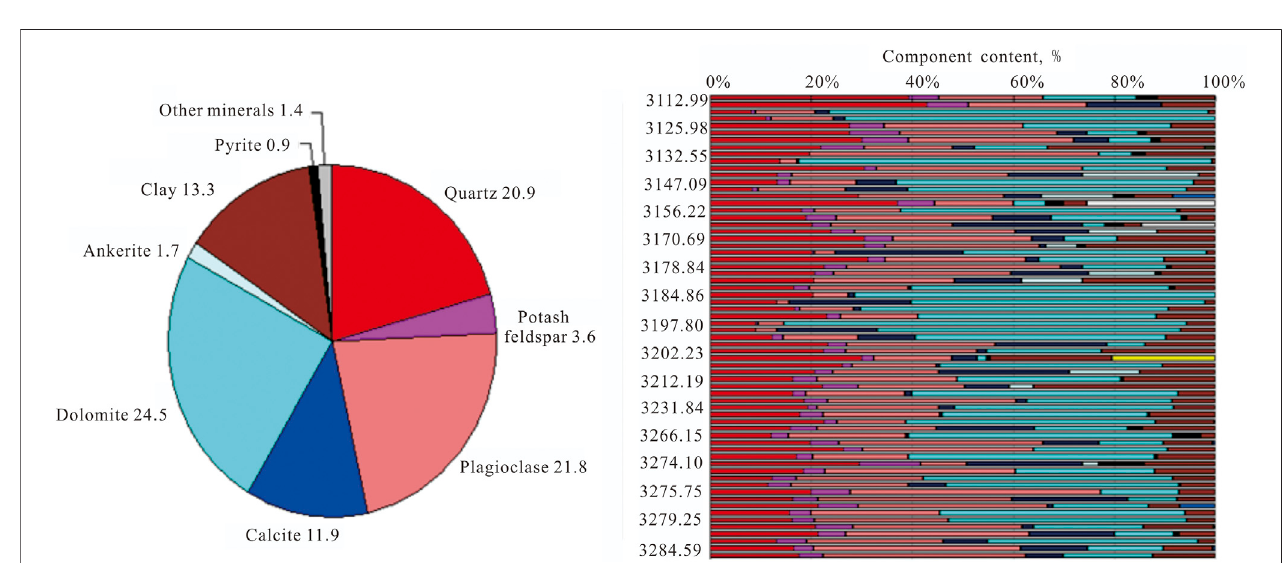
FIGURE 2 | X-diffraction characteristic map of whole rock minerals in the Lucaogou Formation.